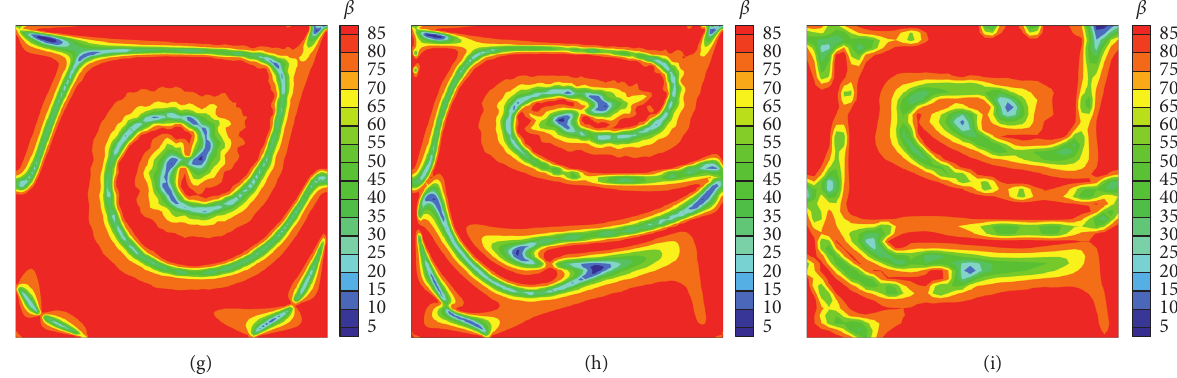
Figure 5: Simulated field synergy for different Re and Ri values. (Re, Ri ) � (a) (100, 0.001), (b) (100, 1), (c) (100, 10), (d) (400, 0.001), (e) (400, 1), (f) (400, 10), (g) (1000, 0.001), (h) (1000, 1), and (i) (1000,